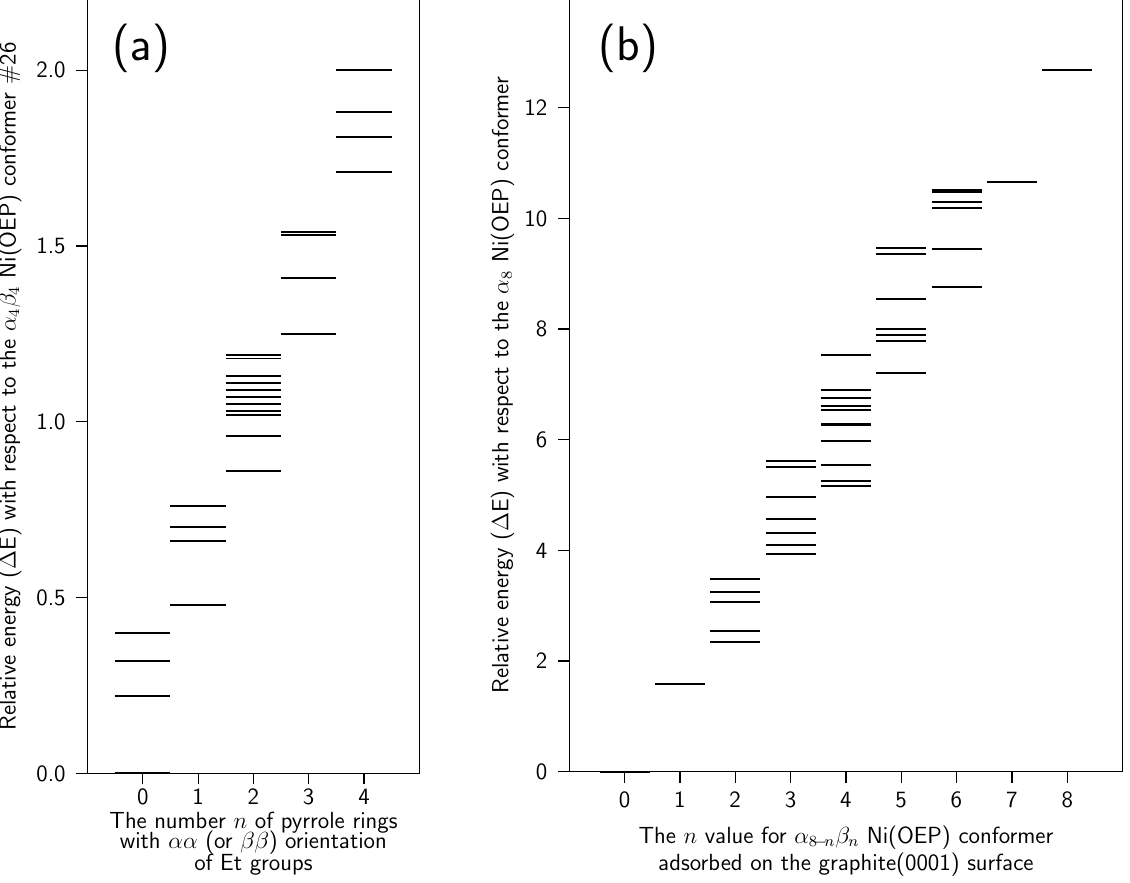
Figure 3 . Energies for: (a) 28 isolated Ni(OEP) conformers, and (b) 43 conformations of the Ni(OEP)–graphite